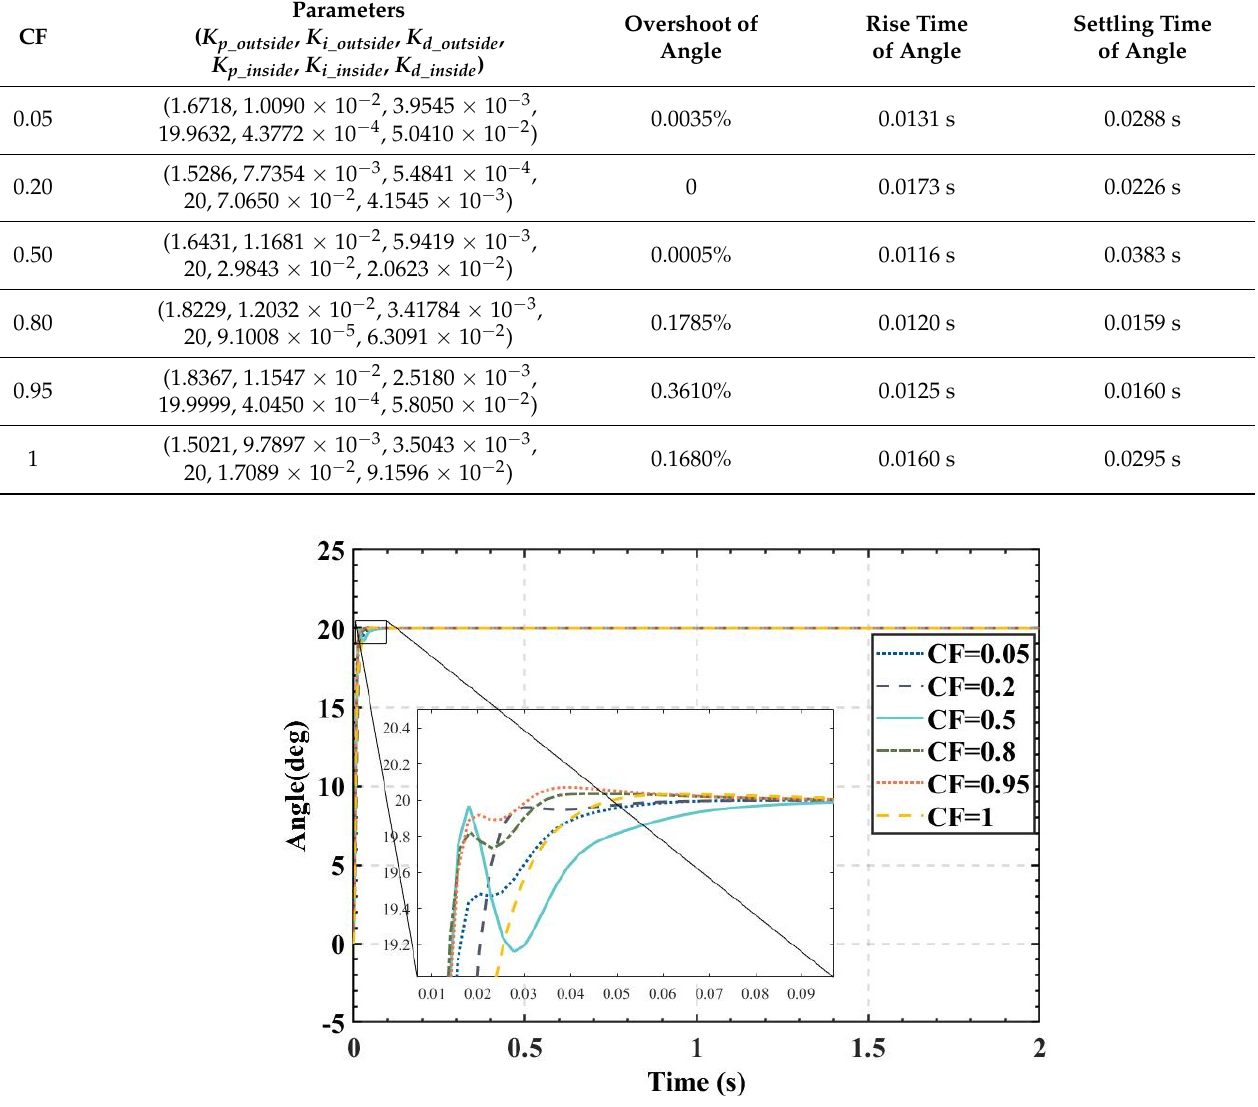
Figure 17. Actual angle of the balancing robot under CFHBA-PID algorithm with different comple- mentary factors. Table 8. Attitude control of balancing robots under CFHBA-PID algorithm with different comple- mentary factors.